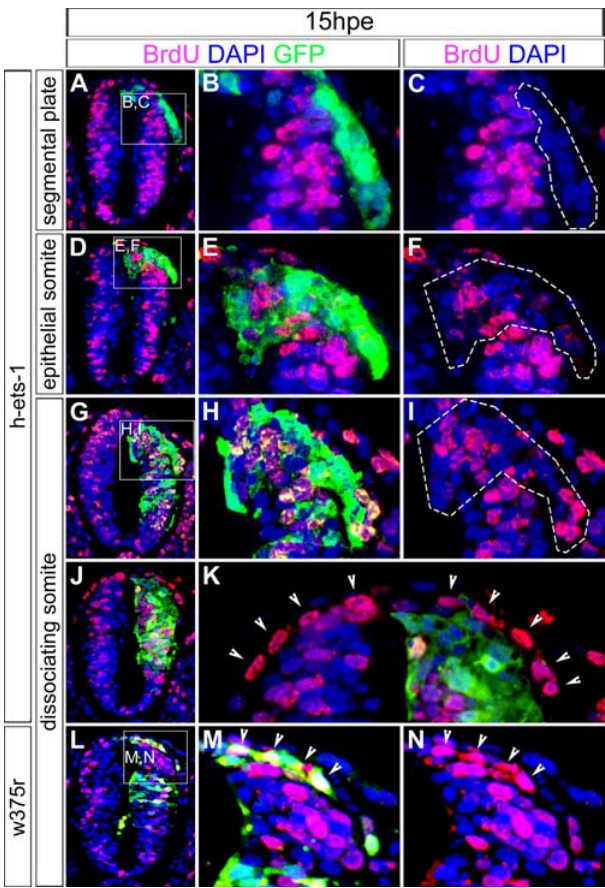
Figure 5. Ets-1Misexpression Emancipates Trunk NCC Delamination from Subordination to Successful G1/S Transition. (A–N) Analysis of the effects of h-ets-1 misexpression in trunk dorsal neural tube on cell cycle assayed at 15hpe. Immunofluorescence labeling using anti-BrdU antibody of transversal cryosections (5 m m). Nuclei are stained by DAPI incorporation. Dotted lines in (C), (F), (I) indicate delaminating transfected area as defined by GFP expression (B, E, H). Trunk NCCs emigrating precociously from dorsal electroporated neural tube opposite segmental plate (A–C) or the first epithelial somite (D–F) are not synchronized in S-phase. Similarly, opposite dissociating somites (G–I), h-ets-1 misexpression in the dorsal neural tube leads to increased NCC delamination of a mix of BrdU positive and negative cells. In contrast, trunk NCCs are predominantly in S-phase when h-ets-1 misexpression does not target the most dorsal territory (J–K, arrow heads) or when NCCs are transfected by w375r (L–N, arrow heads).